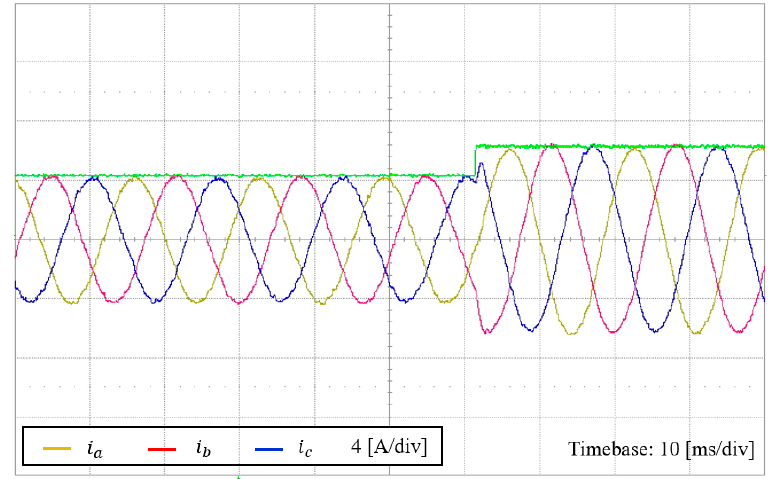
Figure 19. Experimental result of the transient response for the proposed control scheme.